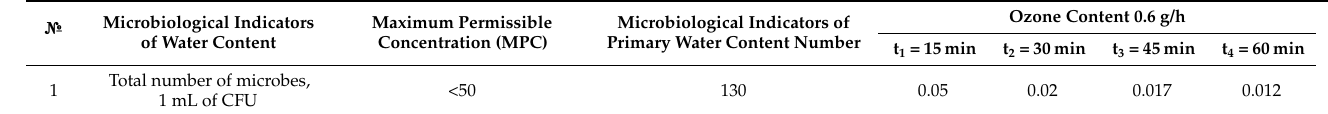
Table 4. Microbiological indicators of reservoir water content (Gozone =